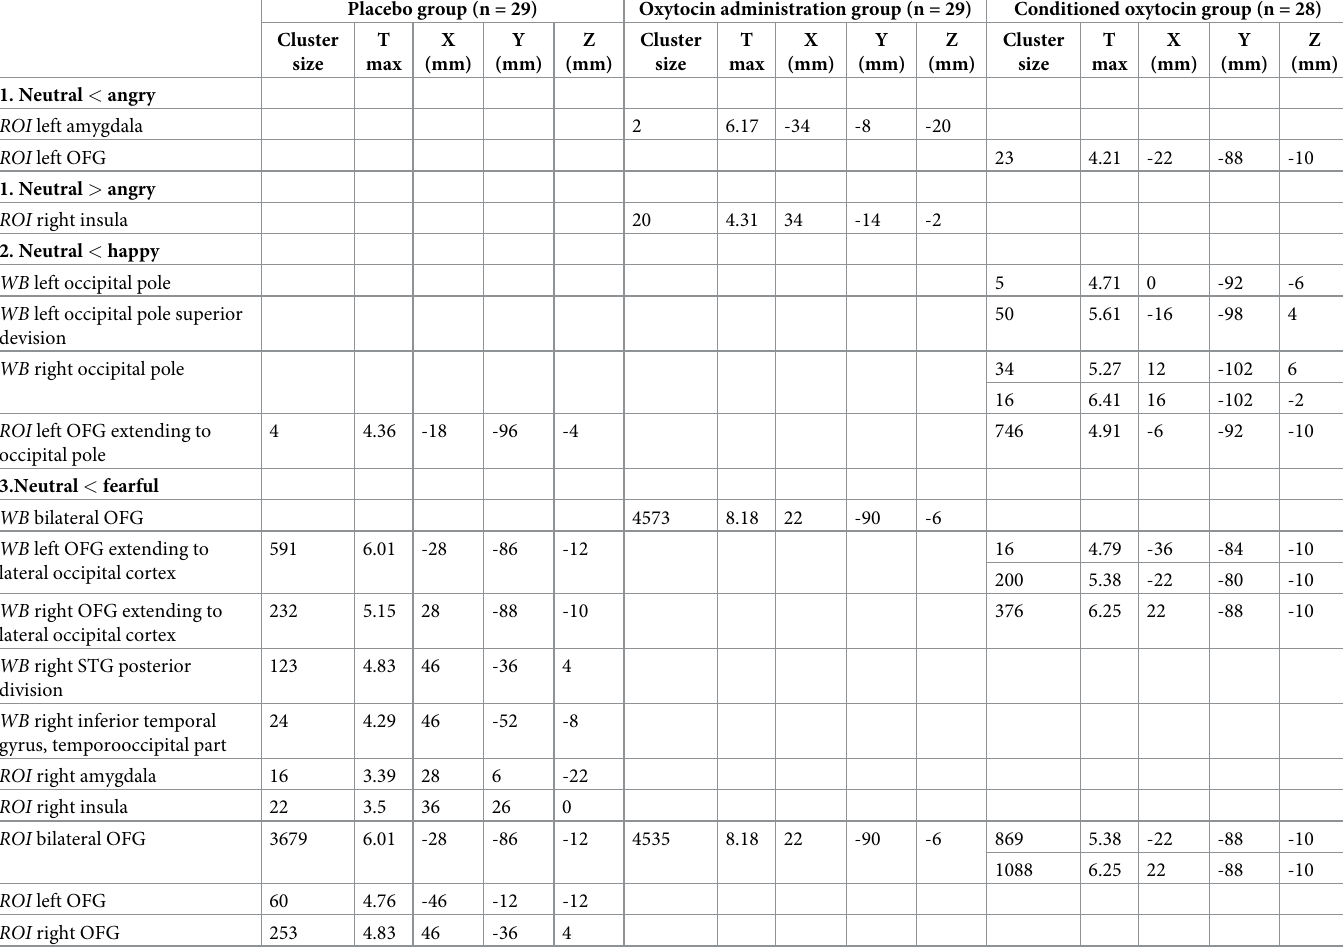
Table 2. Effects of face valence across the groups (second level analysis).